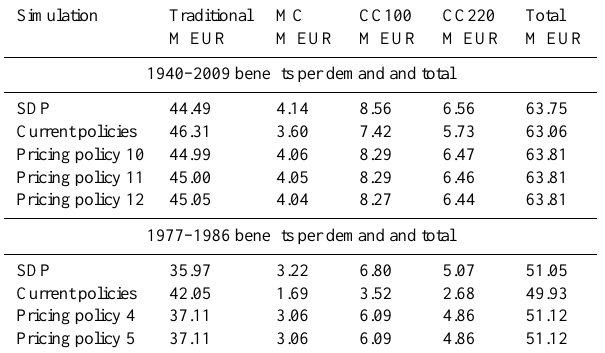
Table 2. Benefits for the 1940–2009 and 1977–1986 periods with stochastic optimization (SDP), current management rules and pric- ing